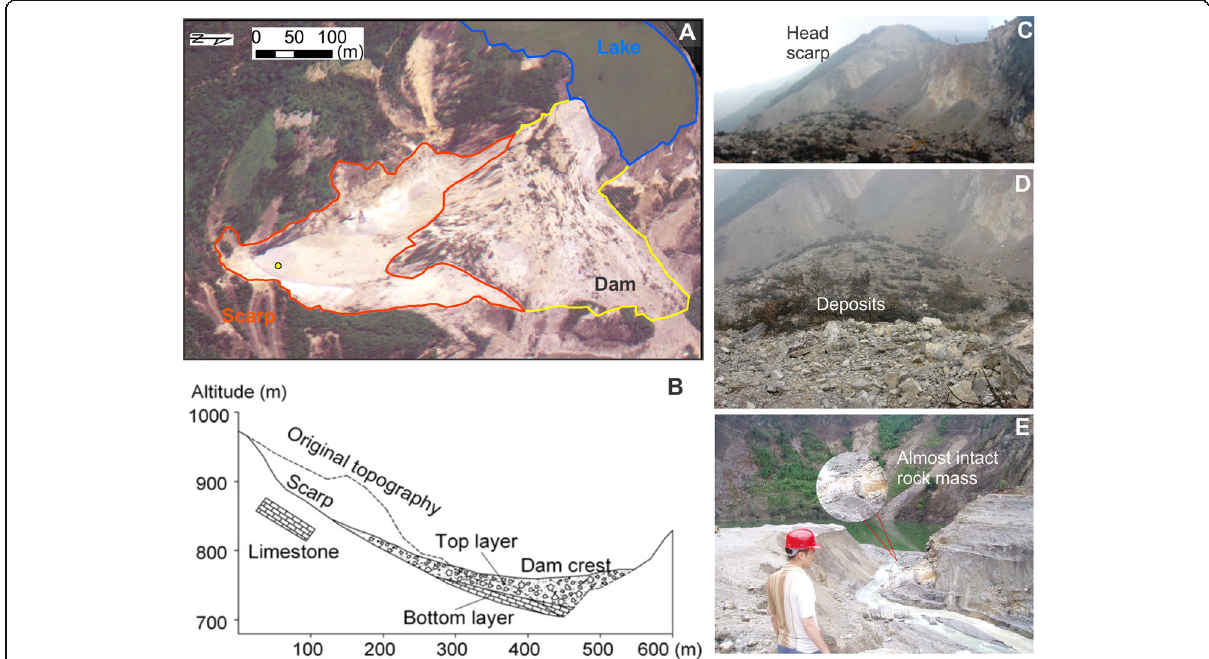
Fig. 10 Xiaojiaqiao landslide. a Aerial photo of the Xiaojiaqiao landslide; b Typical profile of the landslide; c Head scarp; d Depositional zone; and e Exposure of the dam body by an artificial spillway, showing the almost intact rock mass at the